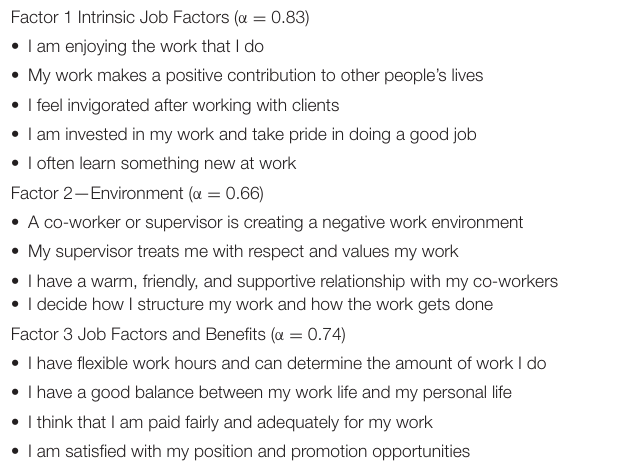
TABLE 6 | Job satisfaction principal component analysis matrix. TABLE 7 | Job satisfaction